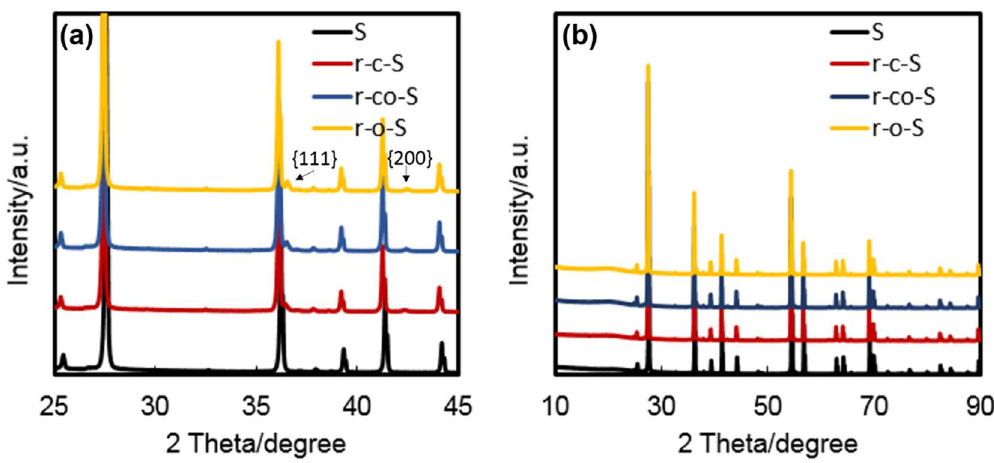
Figure 5. XRD patterns of titania (ST-G2) and FCP-loaded titania. ( a ) is the zoomed-in XRD patterns between 25° to 45°, ( b ) are the {110}, {101} and {211} planes of rutile titania, respectively.